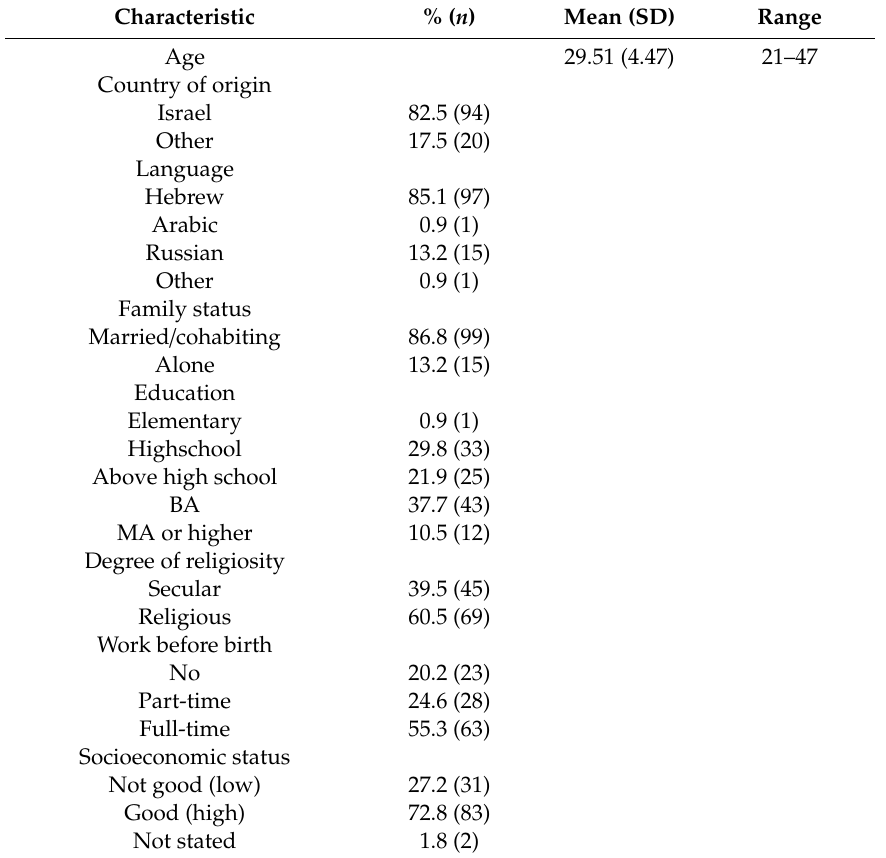
Table 1. Socio-demographic